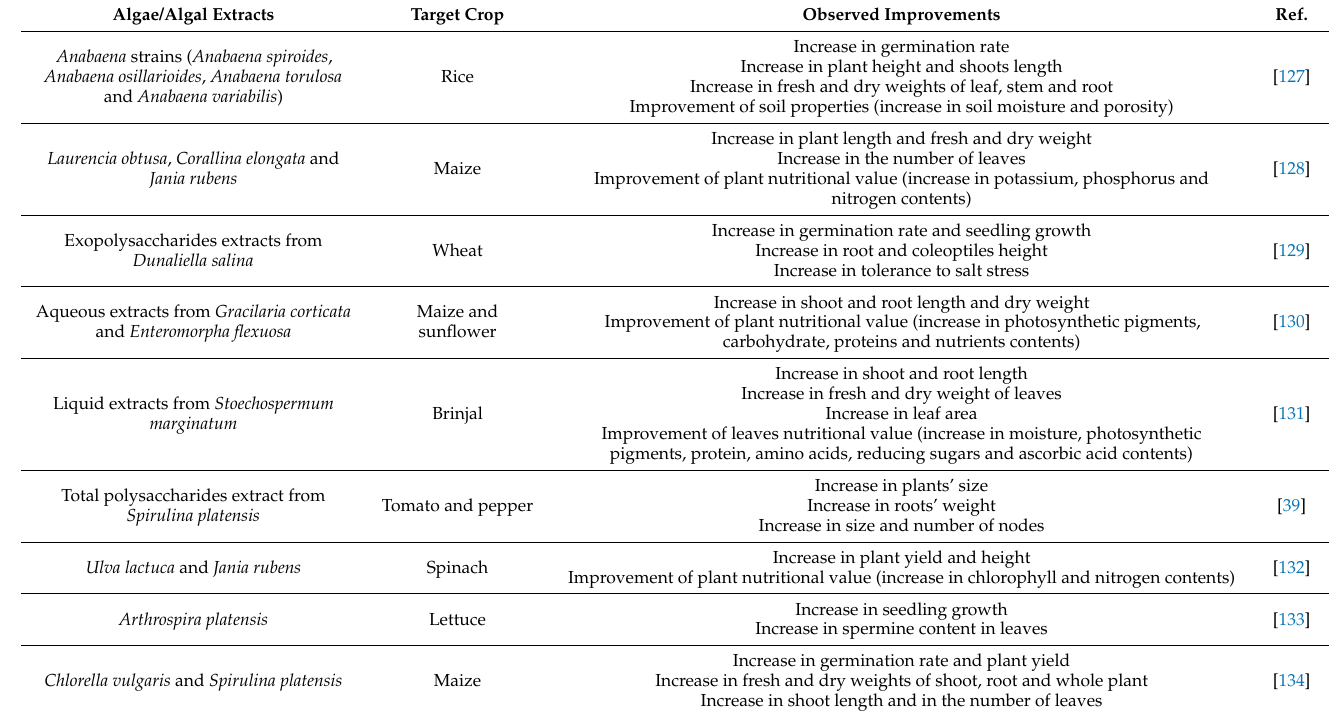
Table 4. Impacts of microalgae and cyanobacteria (and their metabolites) on direct growth stimulation of plants. Algae/Algal Extracts Target Crop Observed Improvements